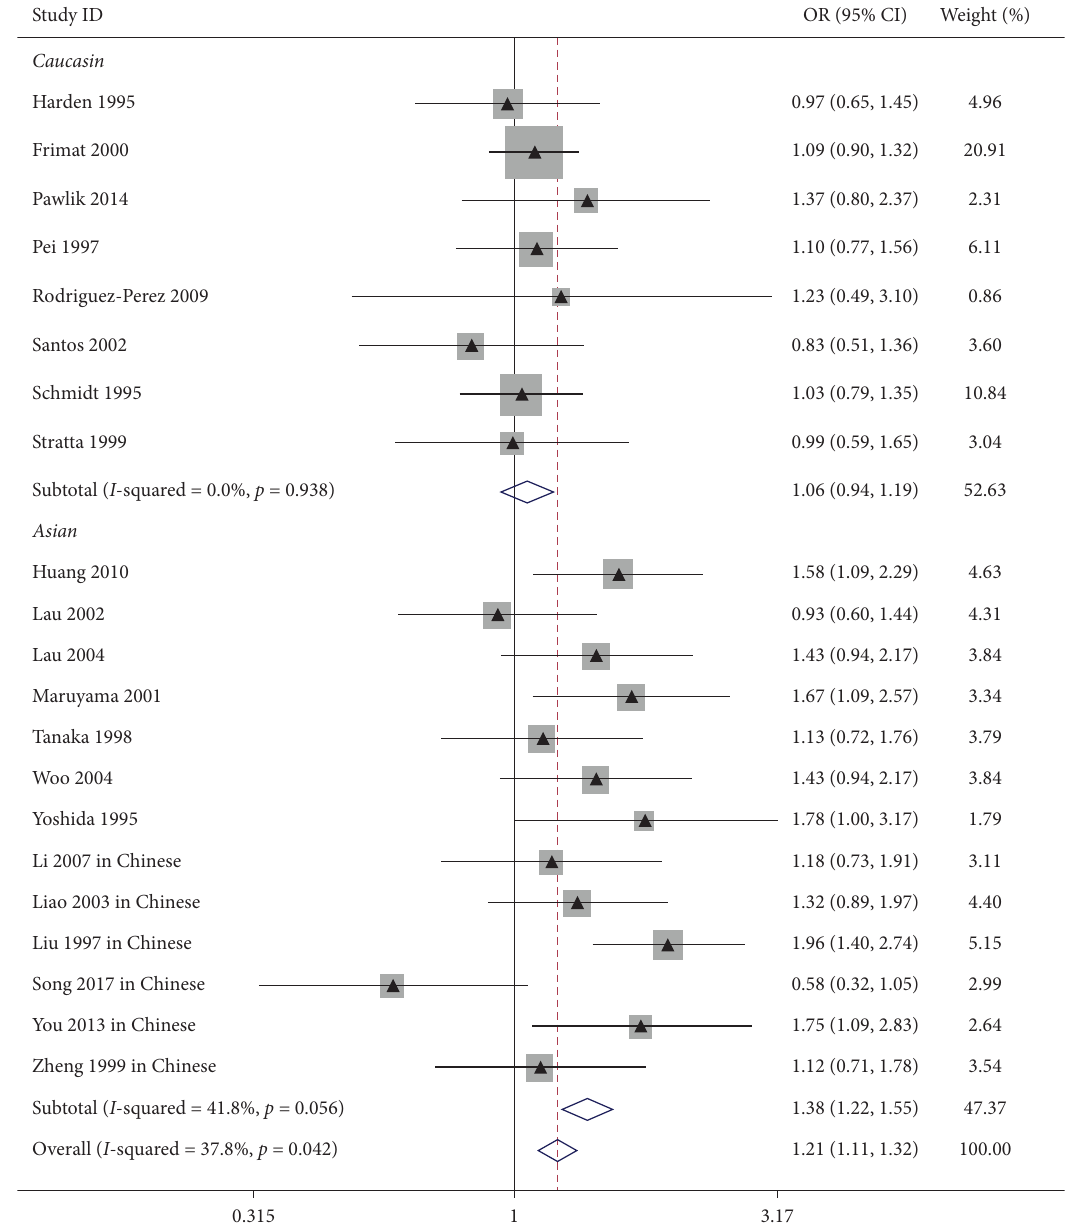
Figure 1: Forest plot of ACE I/ D gene polymorphism linked with IgAN susceptibility (D allele vs. I allele). Pooled analysis indicated that the ACE gene locus D allele was a risk factor of IgAN in the overall and Asian